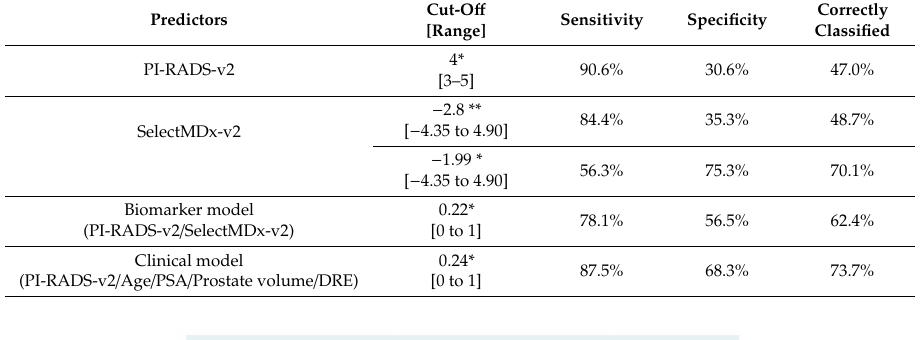
Table 3. Performance of PI-RADS-V2 score, SelectMDx-V2 score, biomarker model and clinical model for predicting high-grade cancer on biopsy. * Cut-o ff value at maximum Youden index. ** As defined by Van Neste and in the SelectMDx-v2 user’s manual.